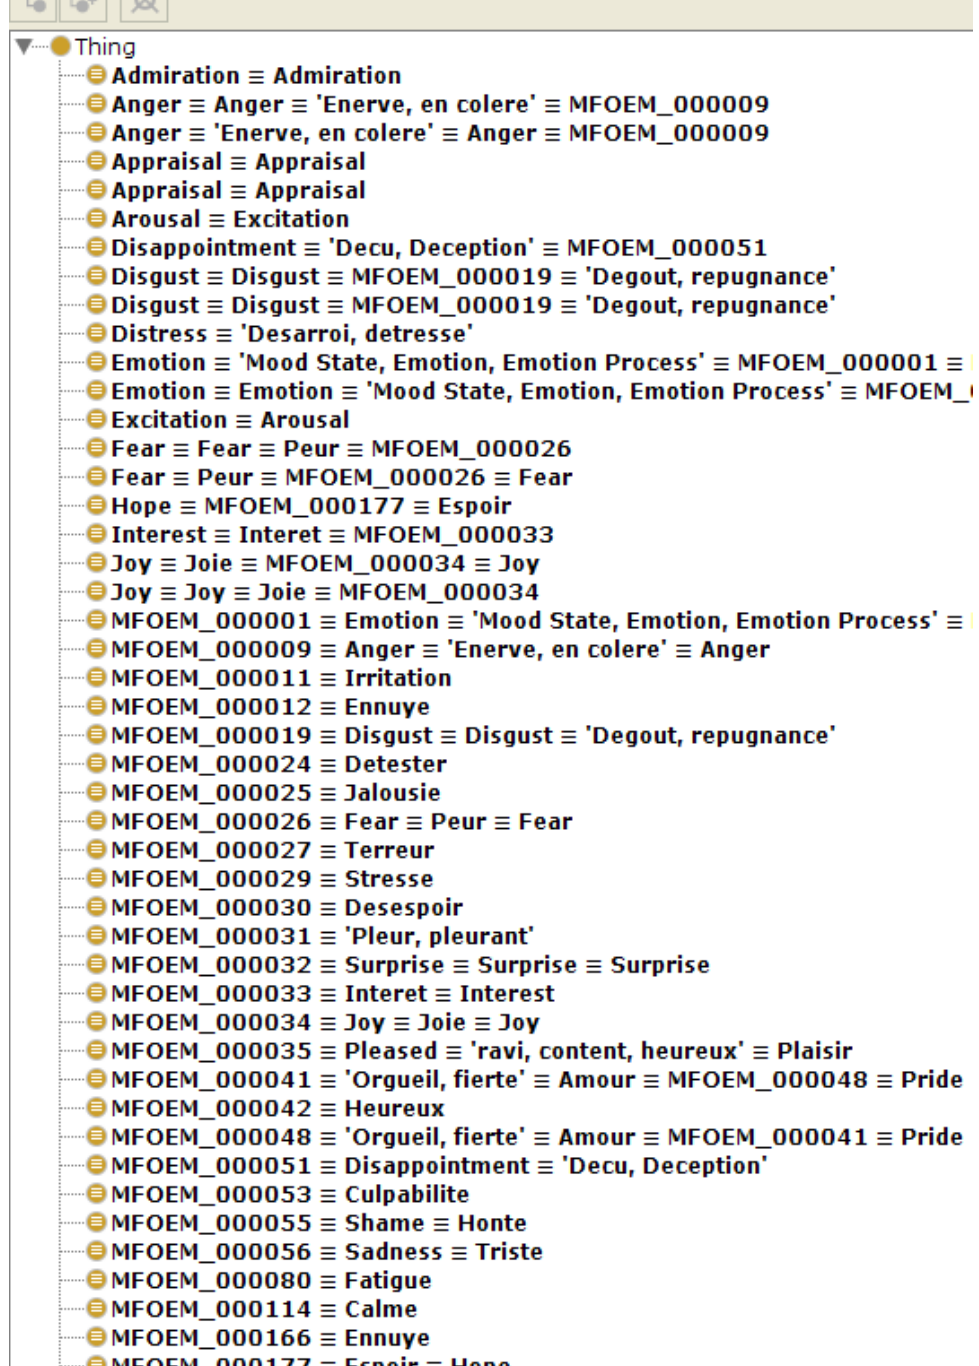
Figure 5. Subset of the emotion ontology (visualization under the Protege ontology